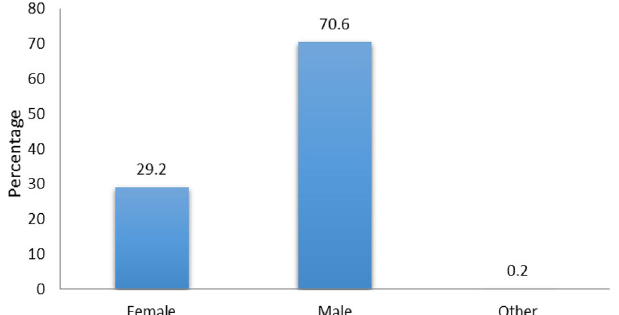
Figure 1. Percentage of gender wise responses. The bar chart represents percentages of respondents belonging to different genders.